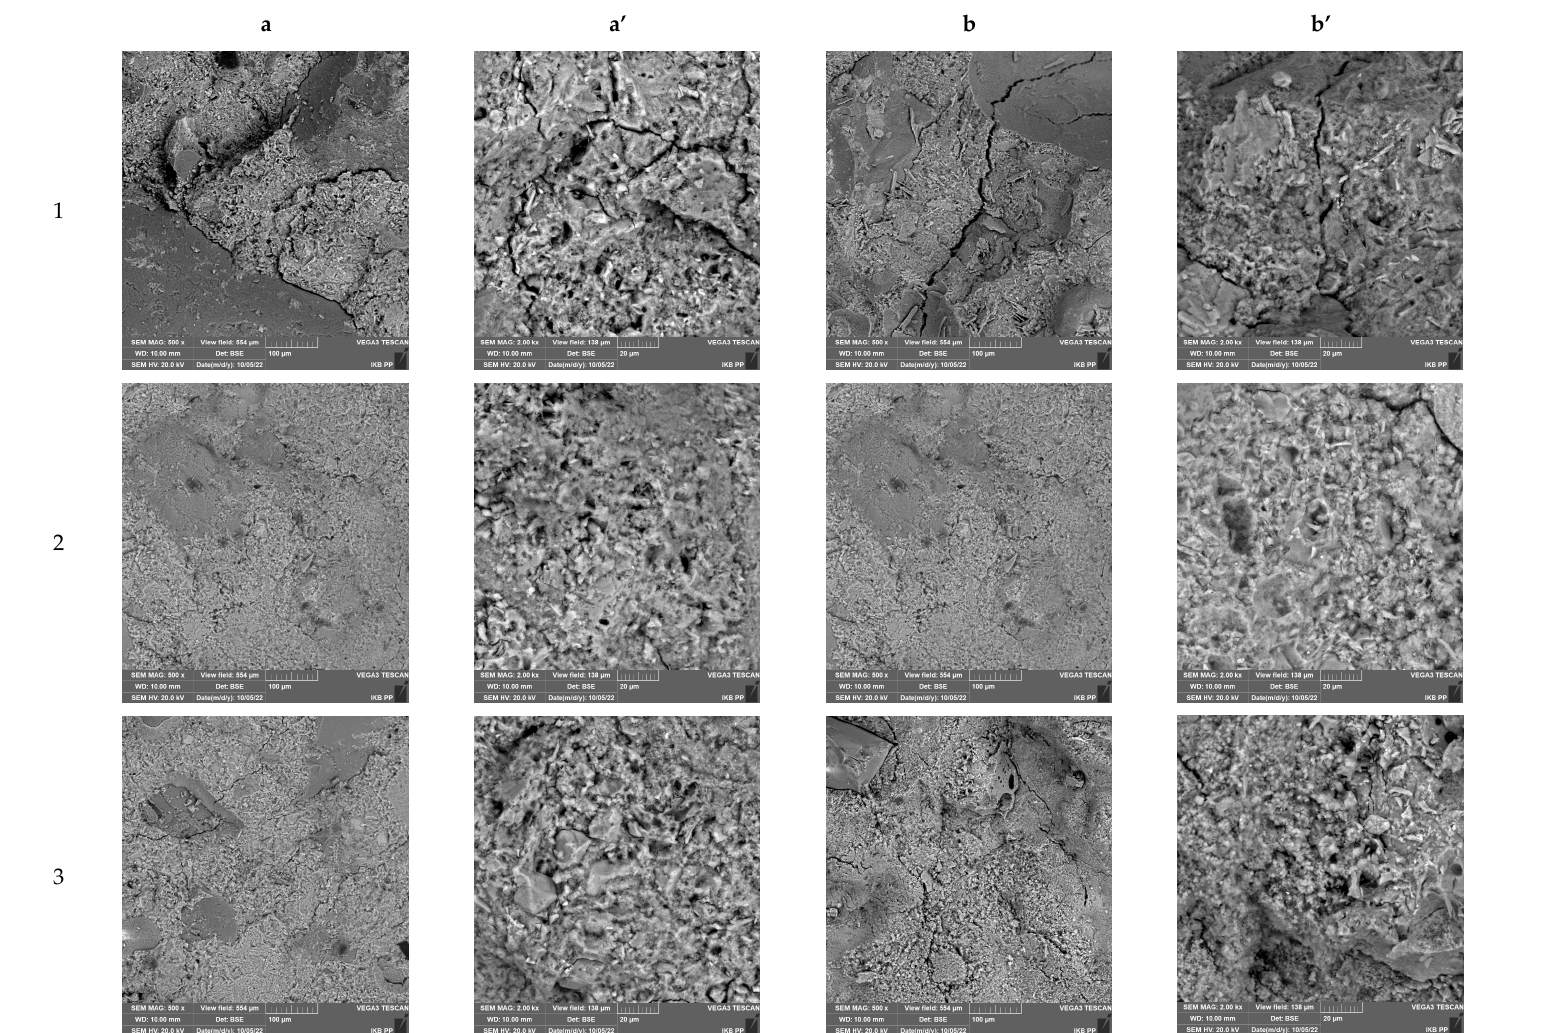
Figure 16. SEM images of cement mortars based on sand and slag and cement CEM 52.5 without freezing–thawing test ( a , a’ ) and after freezing–thawing test ( b , b’